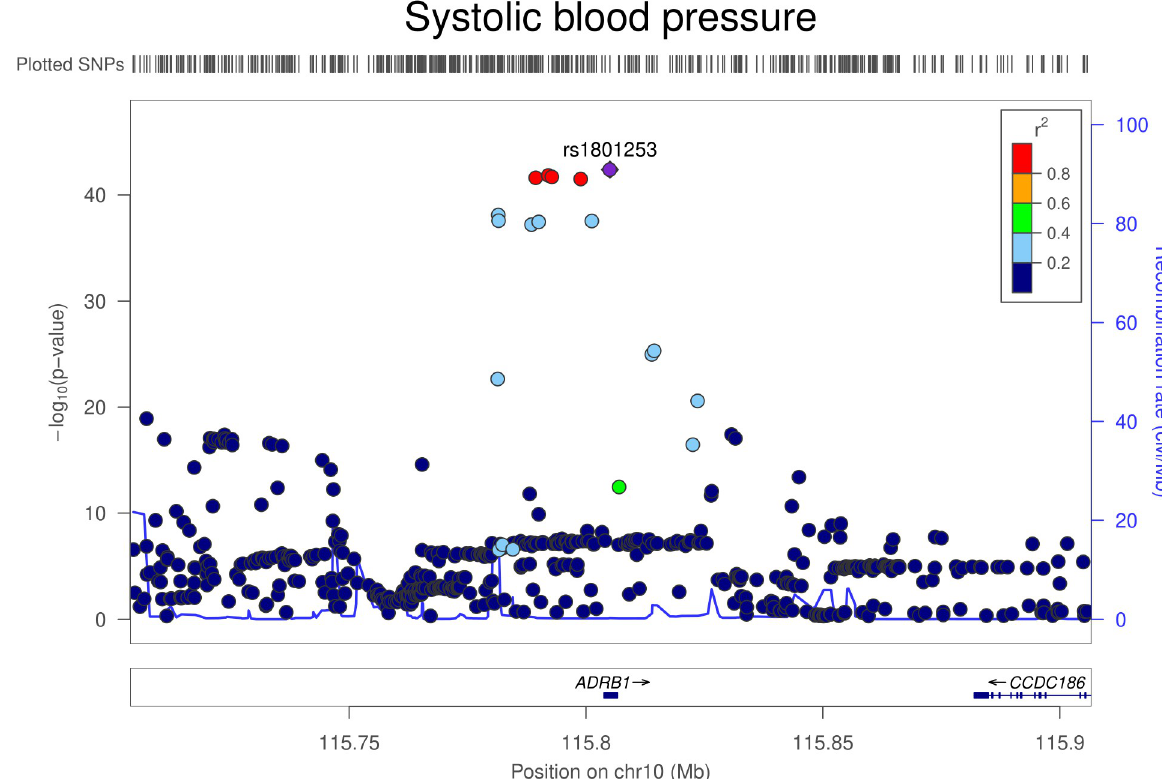
Fig 3. Regional Manhattan plot of associations of SNPs with SBP ± 300kb from the SNP used to proxy SBP (rs1801253) in the ADRB1 region. Mb, Megabase; SBP, systolic blood pressure; SNP, single-nucleotide polymorphism.